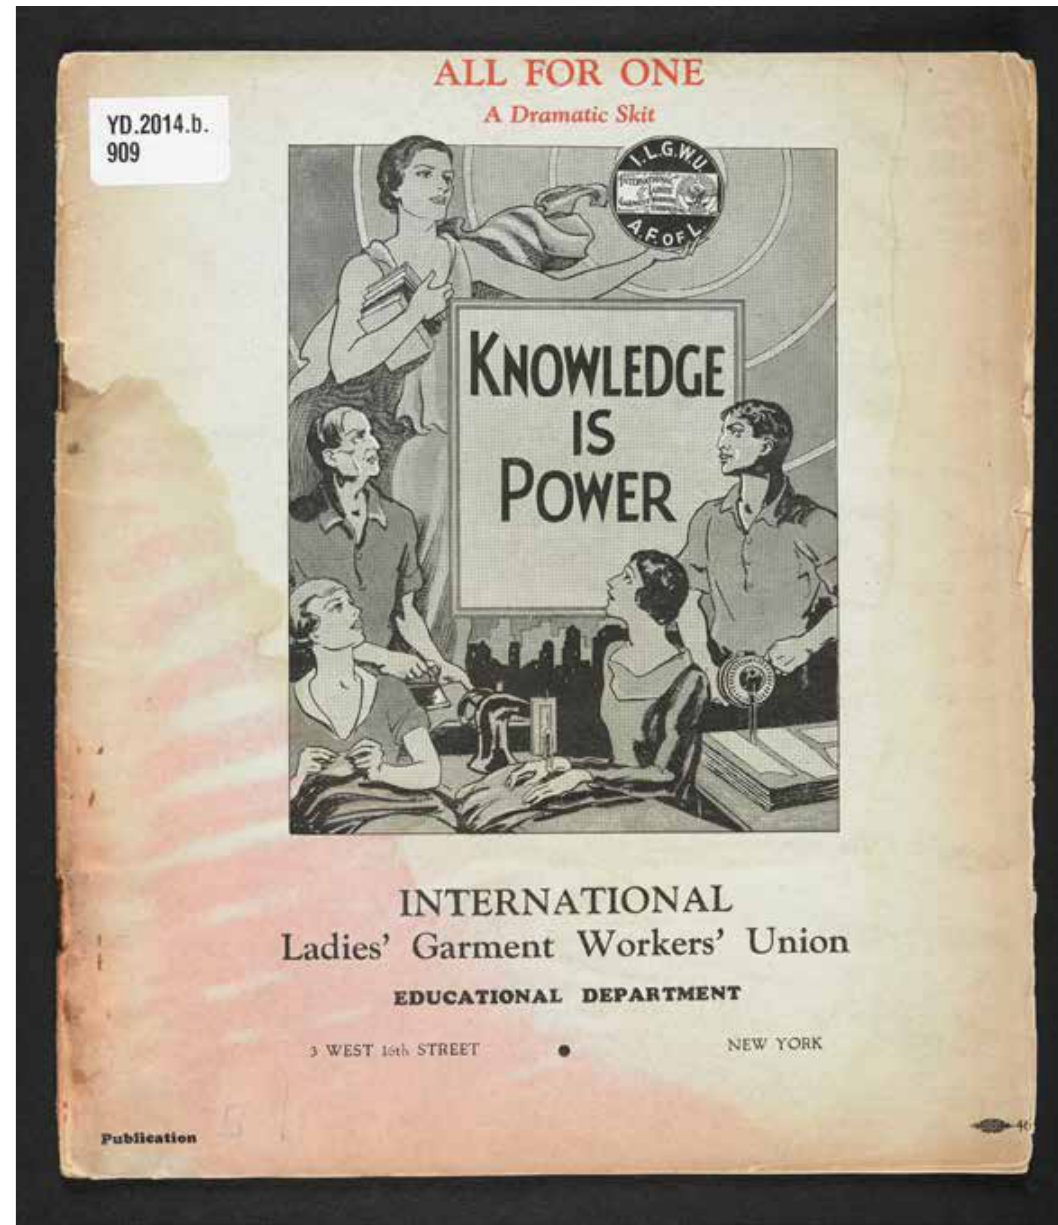
Fig. 4. All For One: A Dramatic Skit (New York: International Ladies’ Garment Union, 1934). BL,